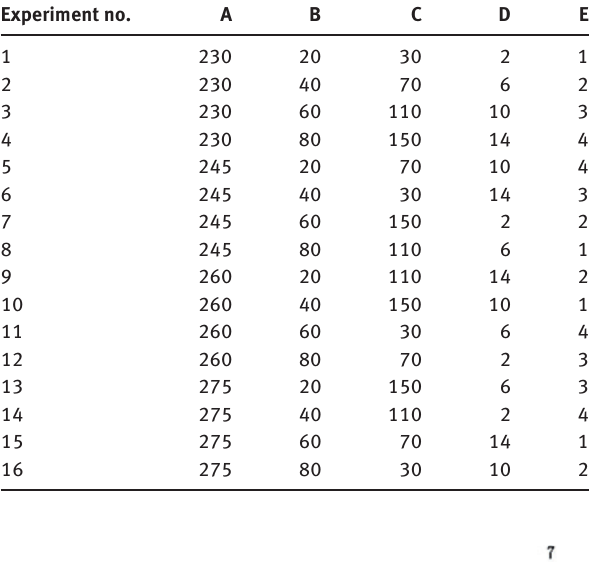
orthogonal array. Table 6: L 16 Experiment no.